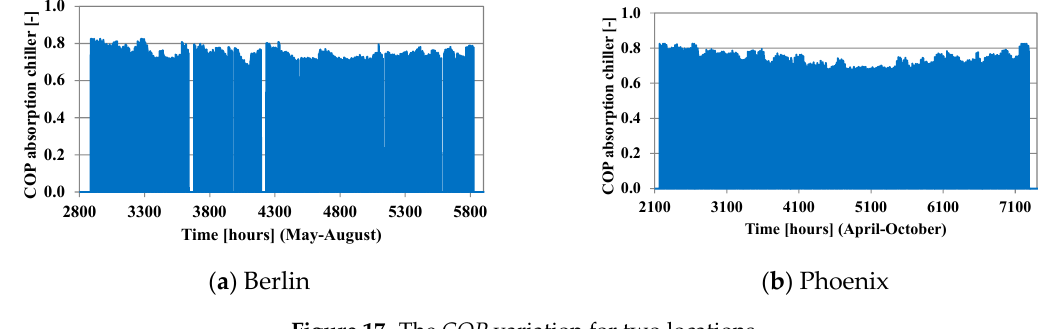
Figure 17. The COP variation for two locations.